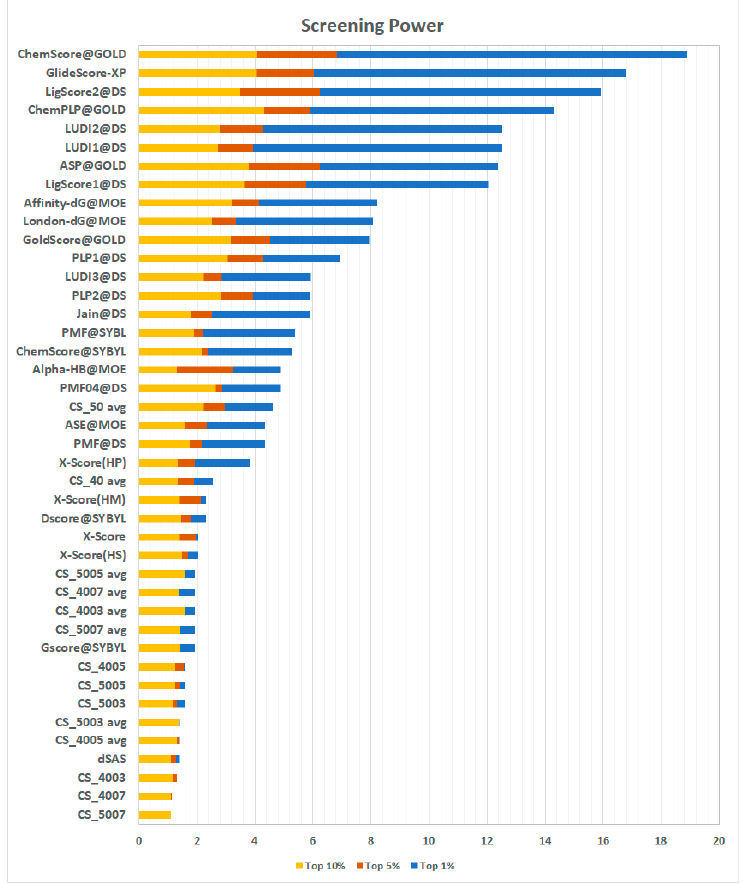
Figure 7. Results of the screening power test carried out on the CASF-2013 benchmark. In the picture, the results of the proposed method by employing both the sum and the average of the fragments’ contact frequencies (the latter identified by the suffix ‘avg’) are shown. The results are represented in terms of the enrichment factor achieved in the best scoring top 1% (blue bars), top 5% (orange bars), and top 10% (yellow bars) poses.